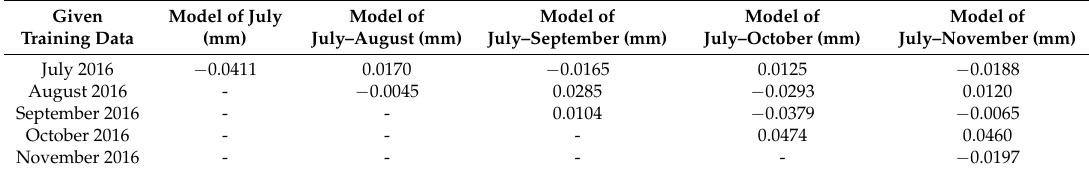
Table 6. Average coverage error (ACE) values with respect to different sets of training data.